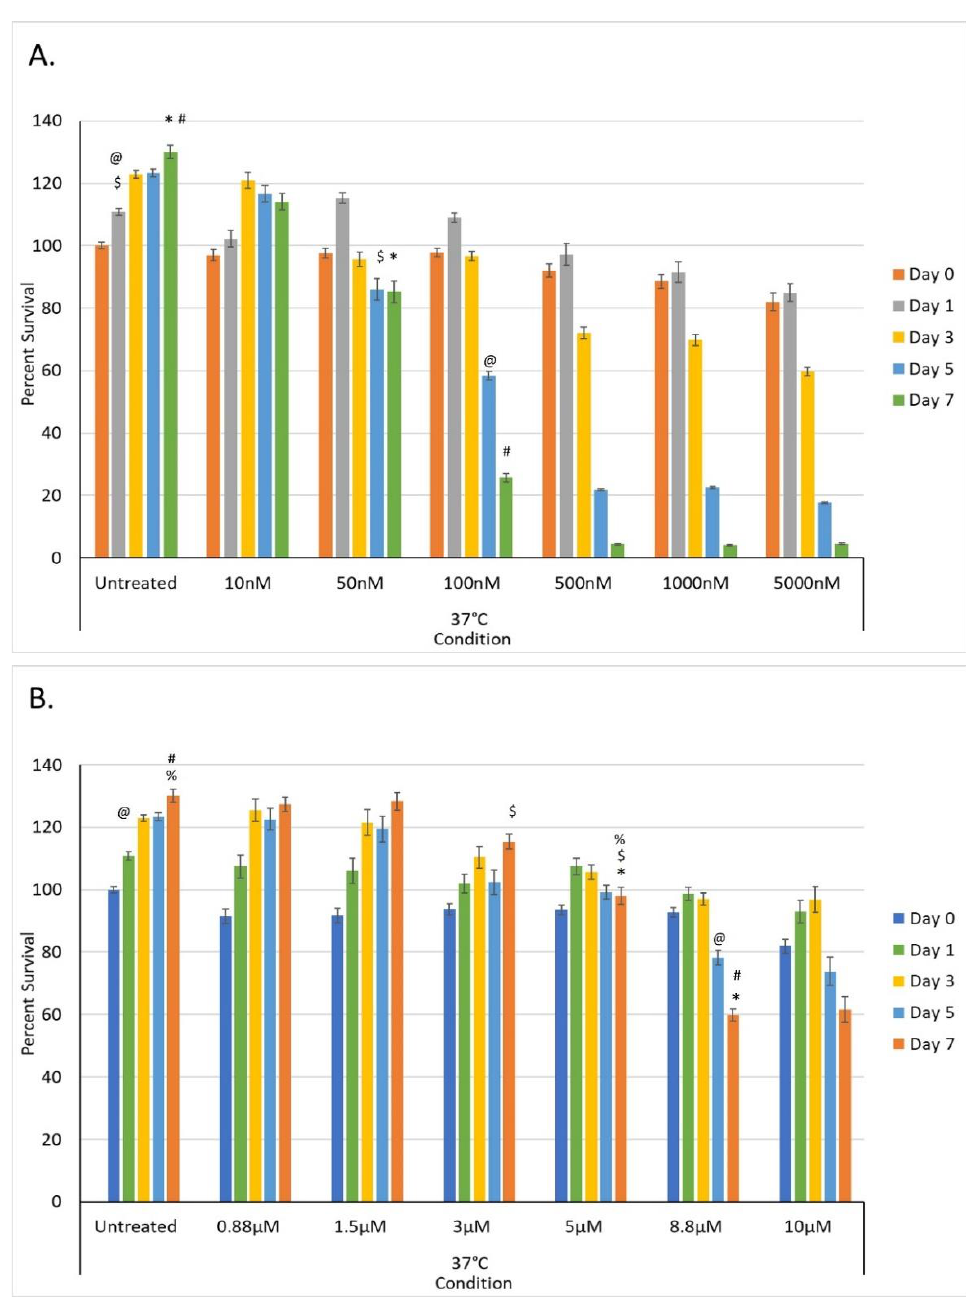
Figure 3. Assessment of the impact of low-dose chemotherapeutic drug exposure on PaCa cell viability in vitro. ( A ) PANC-1 samples were exposed to 10, 50, 100, 500, 1000, and 5000 nM gemcitabine for 48 h. Data revealed that exposure to concentrations <50 nM had minimal impact on cell survival whereas >100 nM resulted in a gradual decline in viability over the 7-day assessment interval. ( B ) PANC-1 samples were exposed to 0.88, 1.5, 3, 5, 8.8, and 10 µM oxaliplatin for 48 h. Data revealed that exposure to concentrations <5 µM had minimal impact on cell survival whereas >8.8 µM resulted in a gradual decline in viability over the 7-day assessment interval (@, #, %, $, * = p < 0.01).